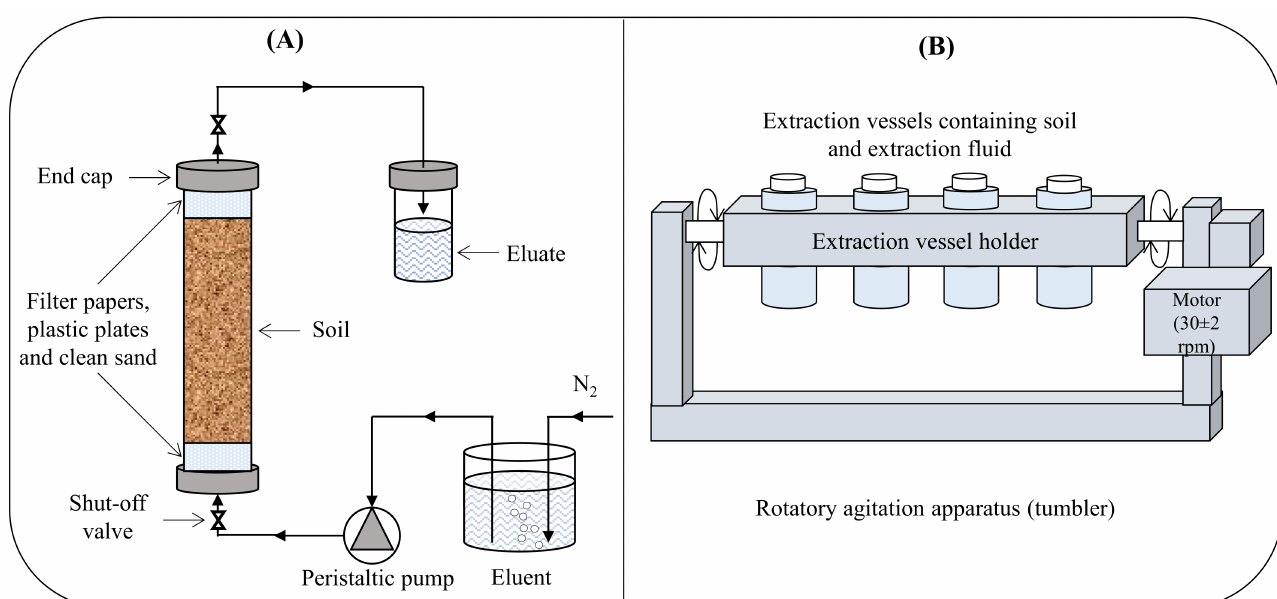
Figure 1. Schematic diagram of the experimental set-up for ( A ) percolation column test and ( B ) toxicity characteristic leaching procedure (TCLP) tumbling